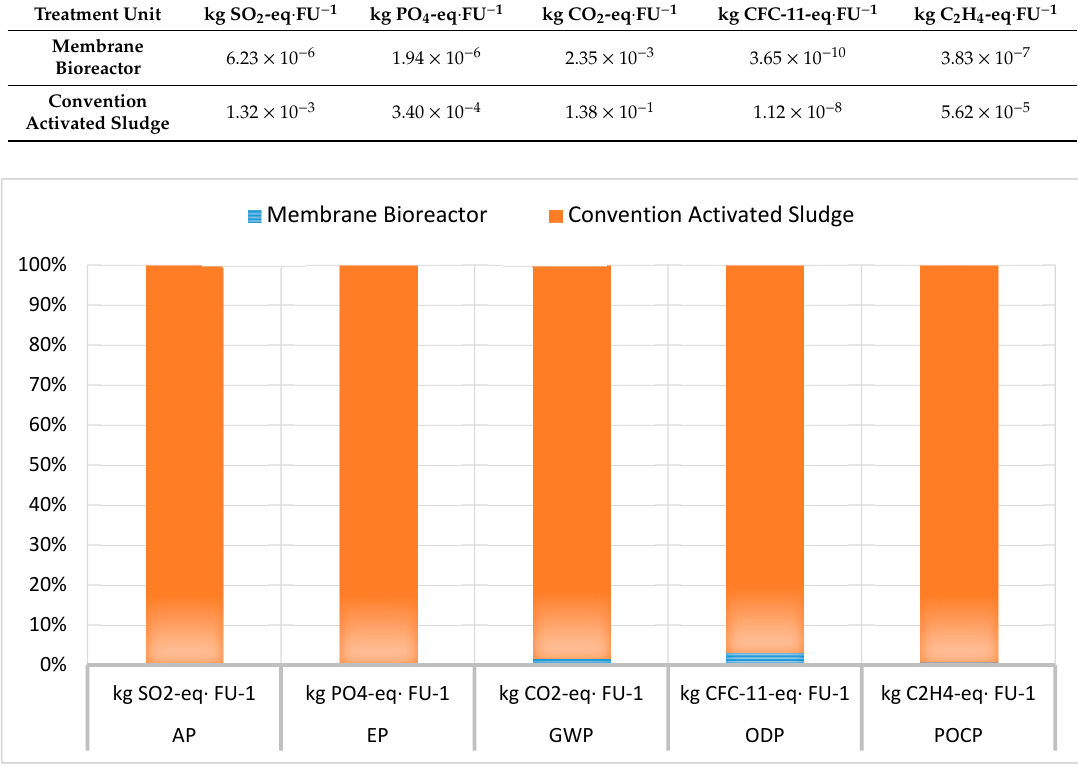
Table 6. LCIA with no sludge removal life cycle contribution.